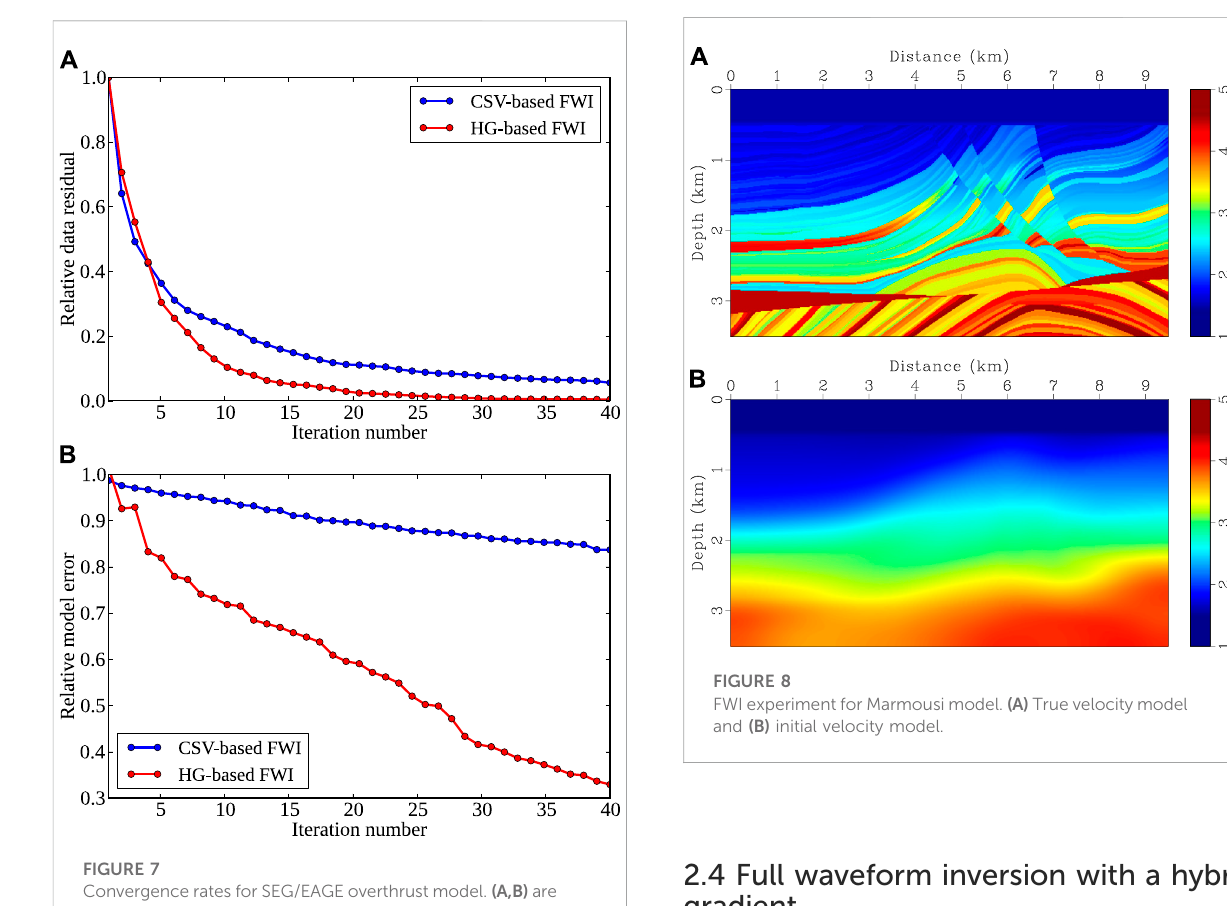
FIGURE 7 Convergence rates for SEG/EAGE overthrust model. (A,B) are relative data residual and model error, respectively. Blue and red lines are results from CSV-based FWI and the proposed HG- based FWI.